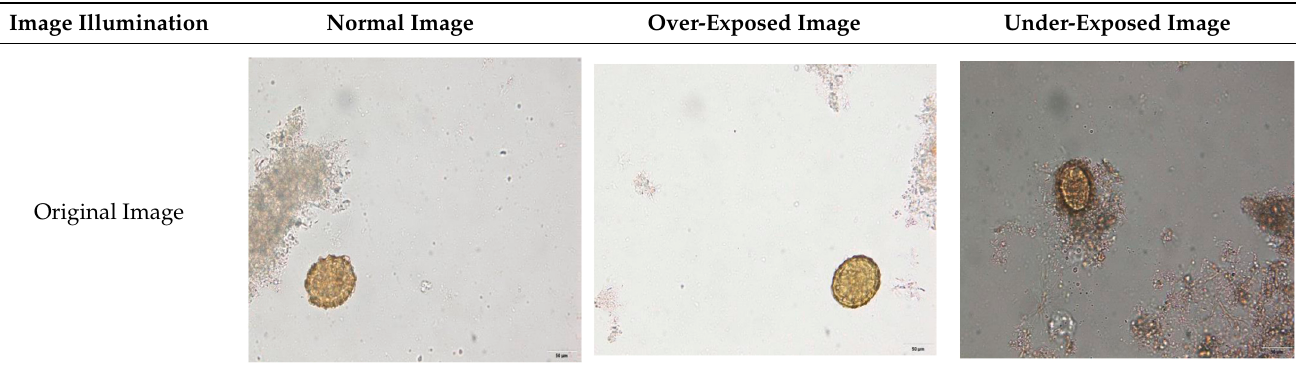
Table 1. ALO image before and after implementing the MGCS technique. Scale bar = 50 µ m.